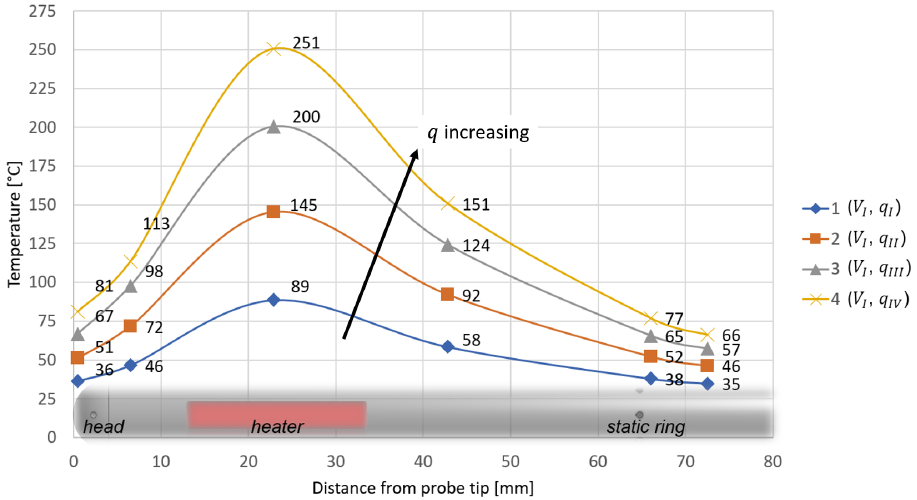
Figure 11. Measured temperature profiles for the test configurations 1, 2, 3 and 4.